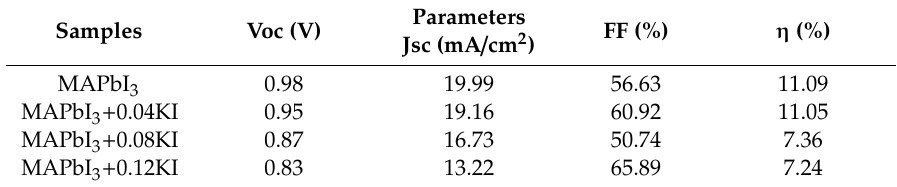
Figure 7. J – V curves of perovskite devices with different K + concentrations. Table 3. Photovoltaic parameters of perovskite devices with different K + concentrations.